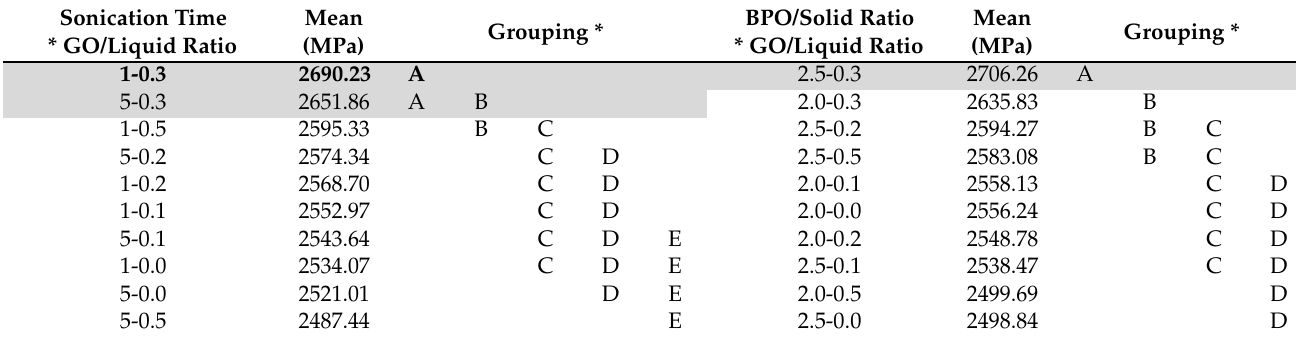
Table 7. Grouping information for the bending modulus using Tukey’s test and 95% confidence. Sonication Time